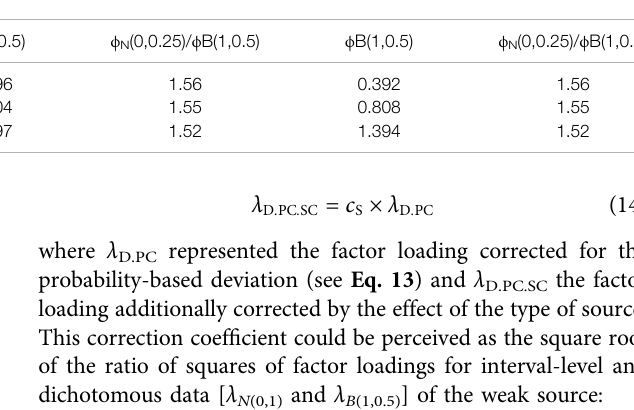
TABLE 4 | Ratios of Variance Estimates for Interval-level Data and Dichotomous Data Showing the Variance of 0.25 for Datasets with 10 and 20 Columns (400 Datasets). Variance estimates based Probability of selected Variance estimates for dichotomous data and ratios of variance on normal data response ∼ N (0,0.25)